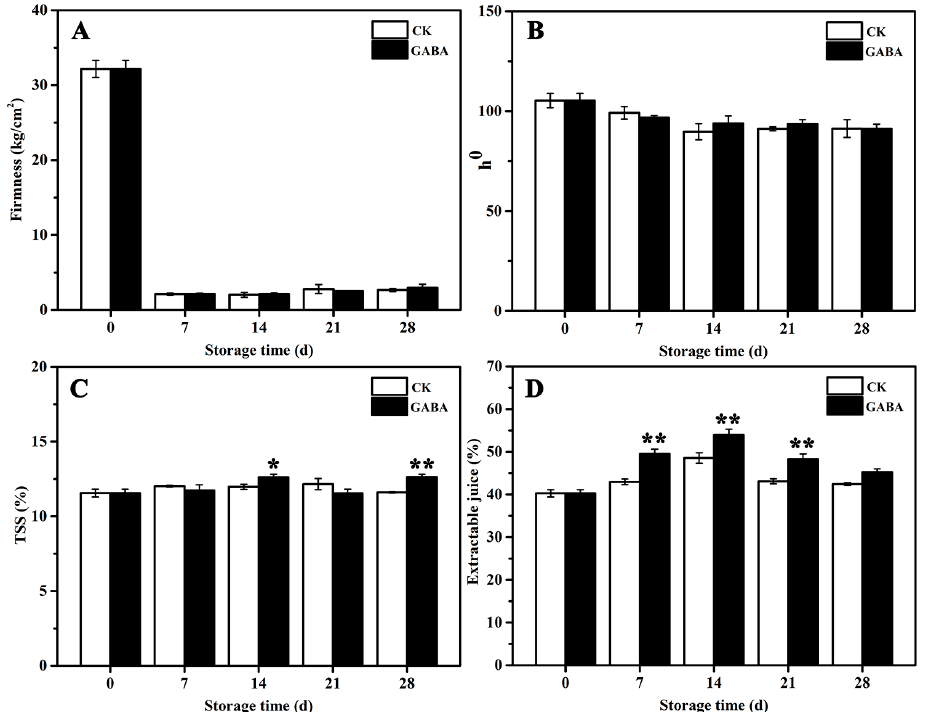
Figure 1. Effect of exogenous GABA on peach fruit quality. ( A ) Firmness, ( B ) L*, ( C ) TSS, and ( D ) extractable juice. All data are expressed as means ± standard errors (SE). Asterisks (*) indicate significant differences between the GABA and CK groups. Unpaired Student’s t -test; (*) p < 0.05, (**) p < 0.01.